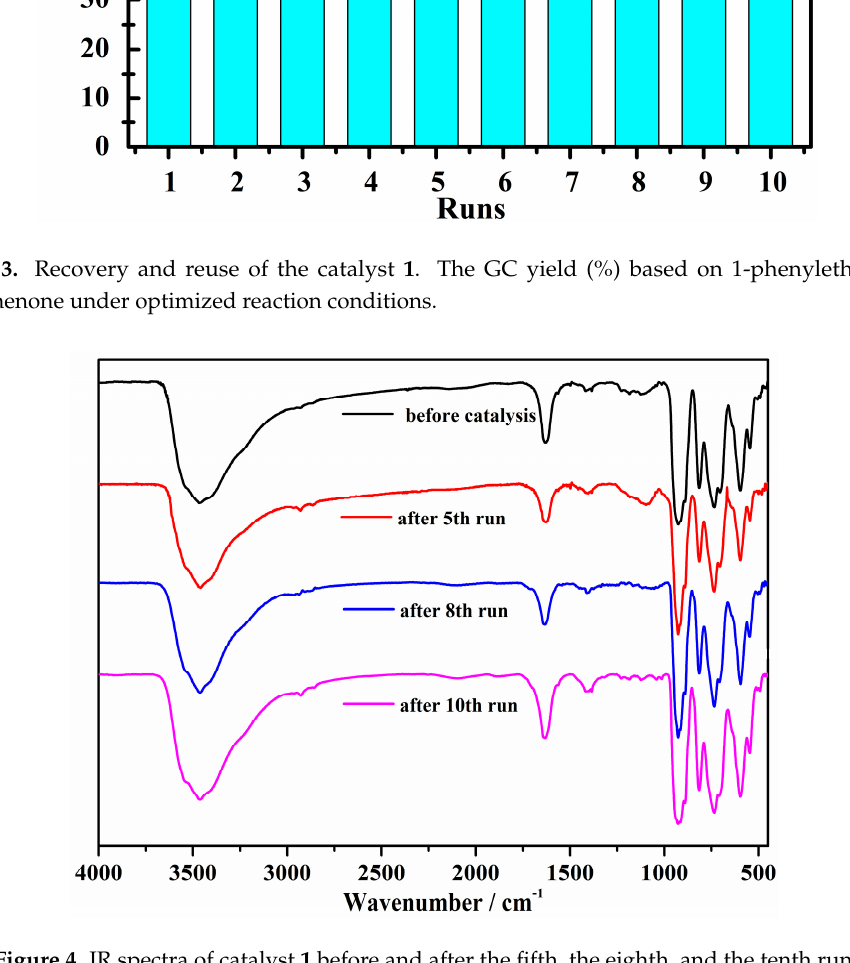
Figure 4. IR spectra of catalyst 1 before and after the fifth, the eighth, and the tenth run.